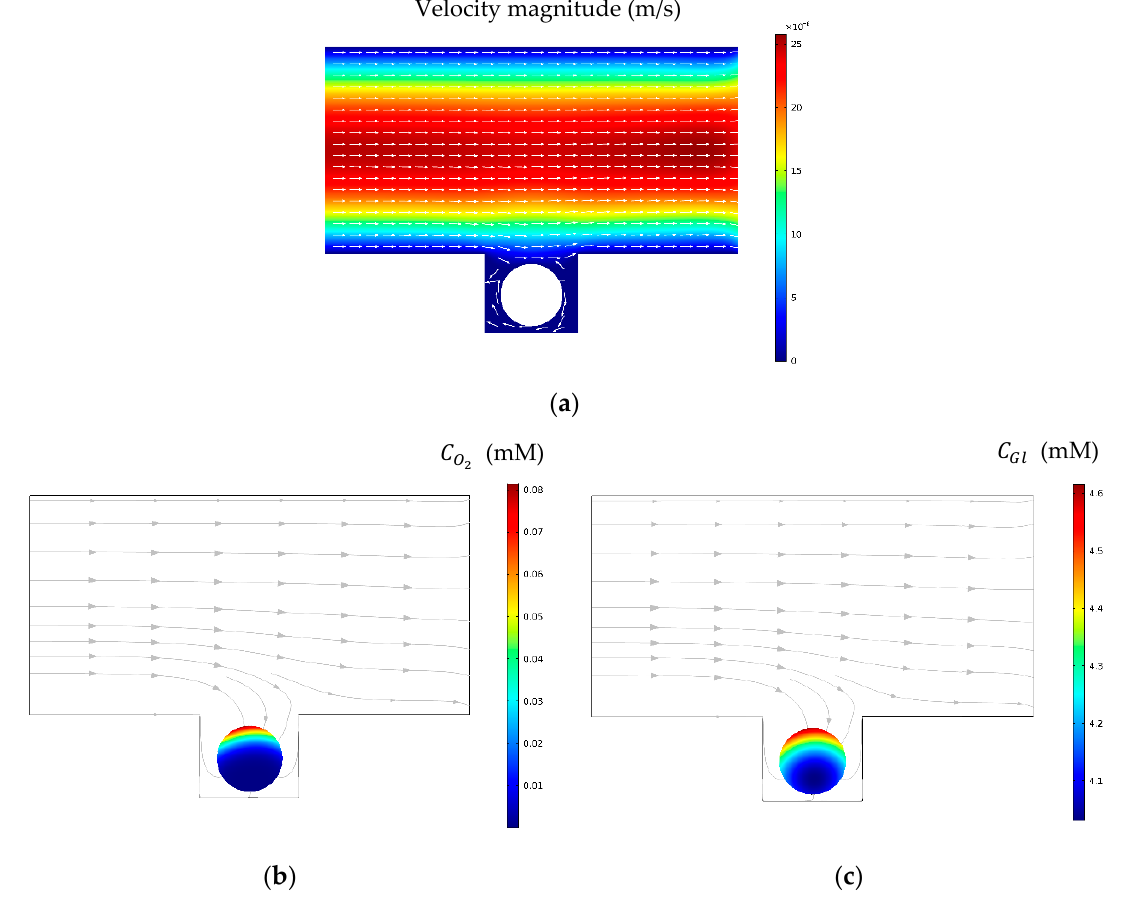
Figure 5. ( a ) Velocity contour and streamlines without acoustics. Velocity distribution is approximately similar to the laminar flow pattern inside a rectangular domain. ( b , c ) Oxygen and glucose concentration distribution and their fluxes. Here, the flow rate was set to be 1 μ L/min.